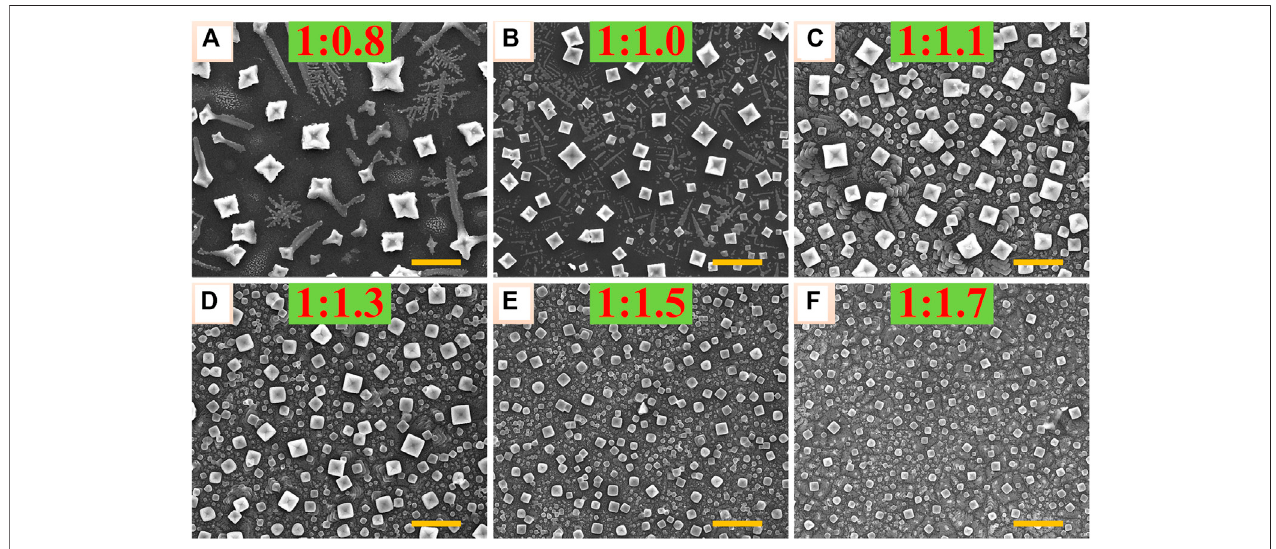
FIGURE1| TopviewSEMimagesofthecorrespondingall-inorganicperovskite fi lmswithdifferentmolarratiosofPbBr 2 andCsBr,suchas (A) 1:0.8, (B) 1:1.0, (C) 1:1.1 (D) 1:1.3, (E) 1:1.5, (F) 1:1.7, respectively. The scale bar is 2 μ m in all images.